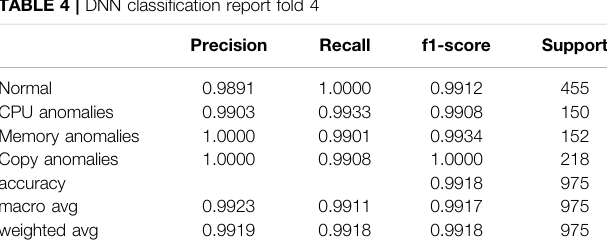
TABLE 4 | DNN classi fi cation report fold 4